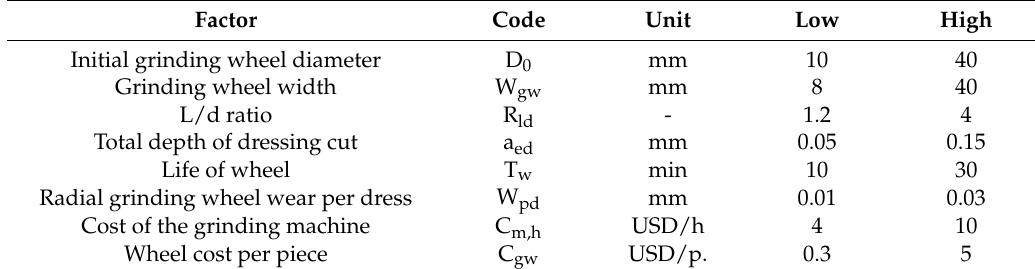
Table 3. Experimental input factors.